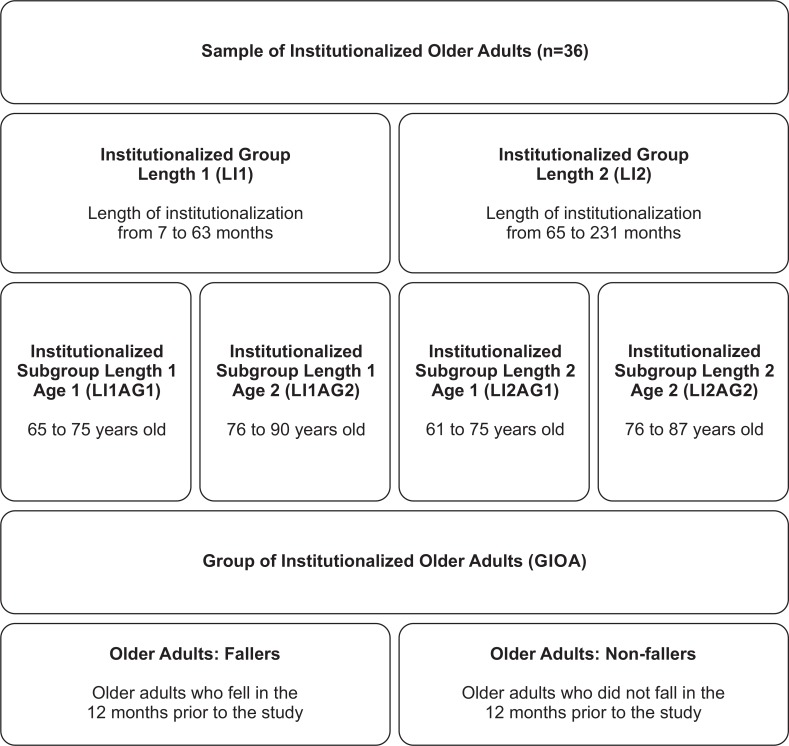
Stratification and homogenization of groups and subgroups of older
adults living in homes for the aged. Três Rios, RJ, Brazil, 2012